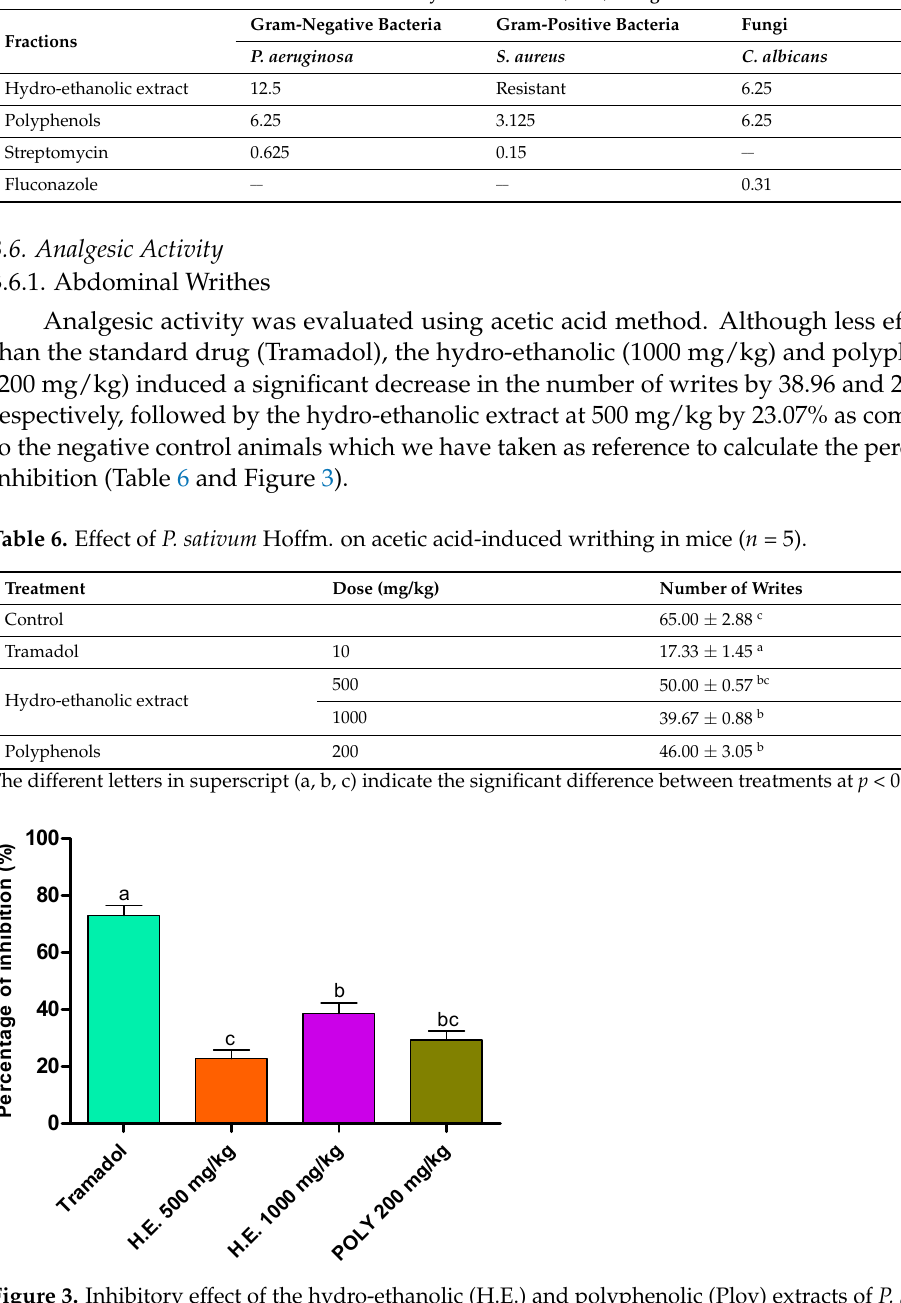
Figure 3. Inhibitory effect of the hydro-ethanolic (H.E.) and polyphenolic (Ploy) extracts of P. sativum Hoffm. and Tramadol (positive control) on contortions in mice. The different letters in superscript (a, b, c) indicate the significant difference between treatments at p < 0.05.